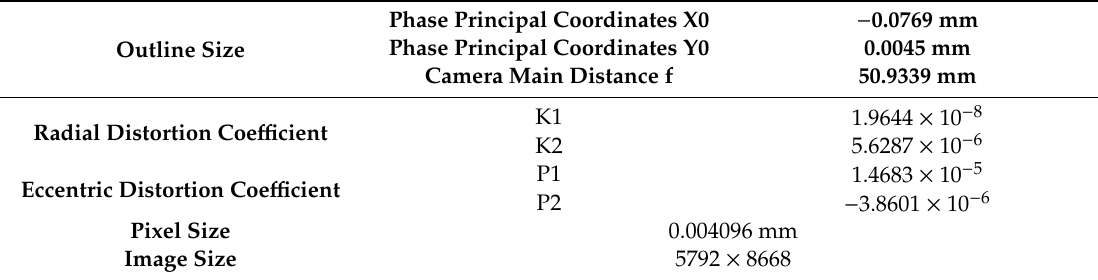
Table 2. Parametric table of camera and lens.